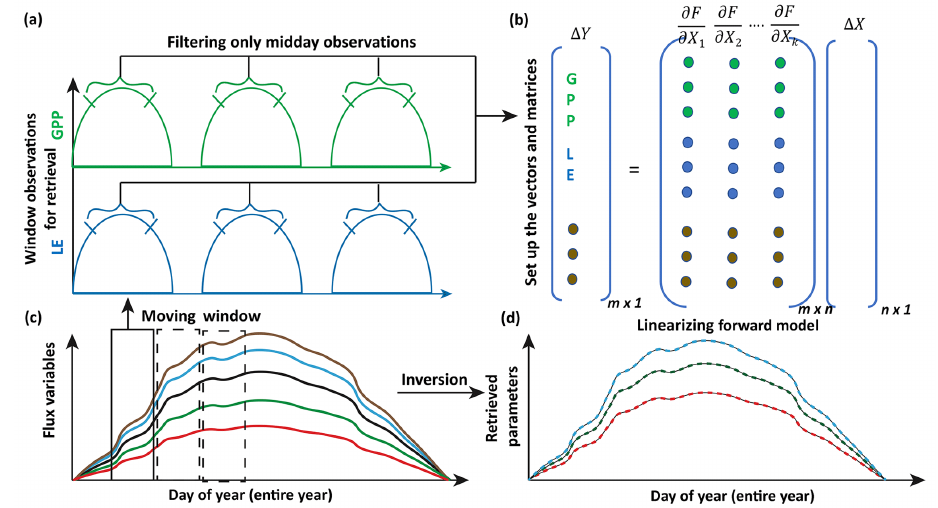
Figure 4. Illustration of moving window inversion retrieval setup. The bottom left part illustrates the annual ecosystem time series flux variables used for driving the SCOPE model. A 3-day time window is selected for each retrieval in the yearly growing season and a time filter is implemented for concatenating the measurement vector (flux tower observations, with each color representing a different observation variable) of length m in the retrieval windows. The top right shows the vector and matrix setup and the linearization of the forward model. (cid:49) Y represents the difference between concatenated observation and modeled vector and (cid:49) X represents the corresponding change in the state vector comprising of n variables (parameters). The bottom right shows the retrieved model parameters after implementing the moving window